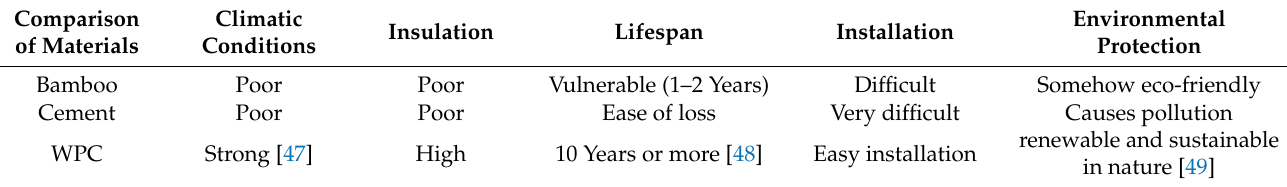
Table 3. Comparison of WPC with commonly used